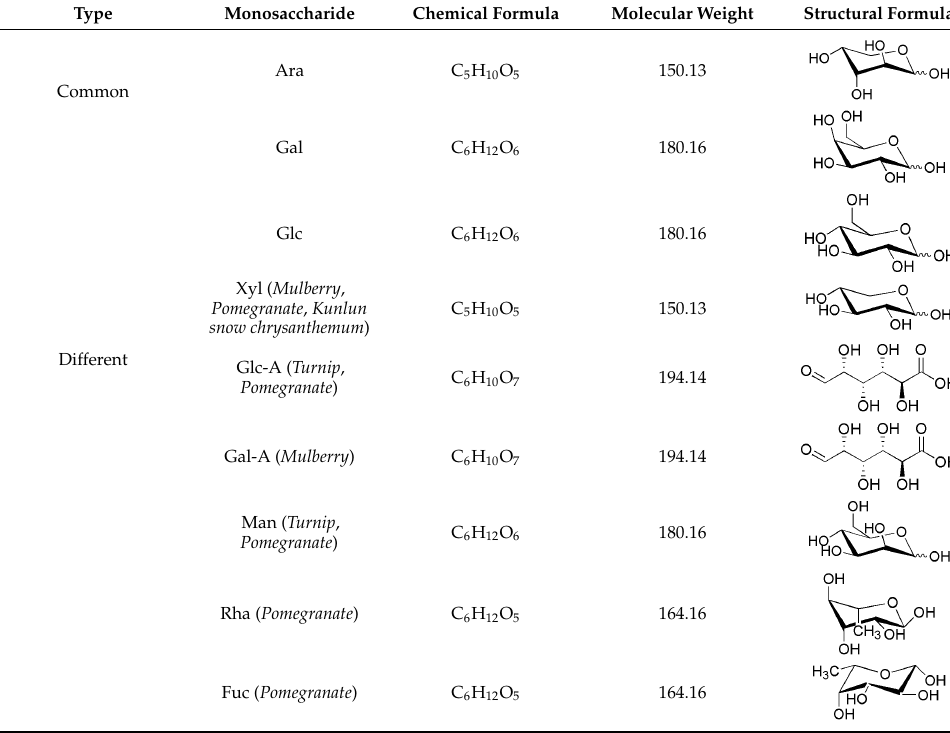
Table 2. Similarities and differences in the medicinal and edible monosaccharides of five Xinjiang specialty plant polysaccharides.